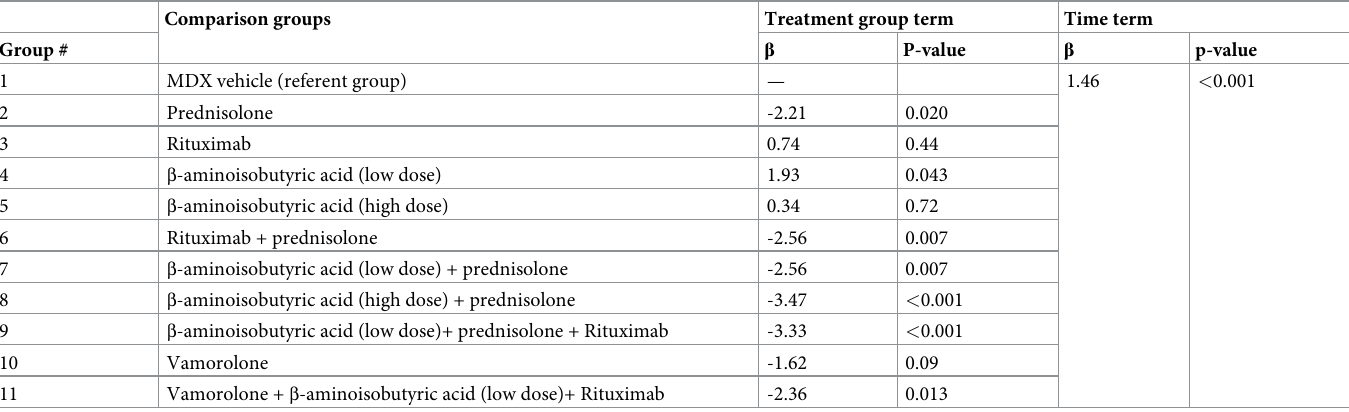
Table 2. Analysis of body weight over time between MDX vehicle and MDX treatment groups. Comparison